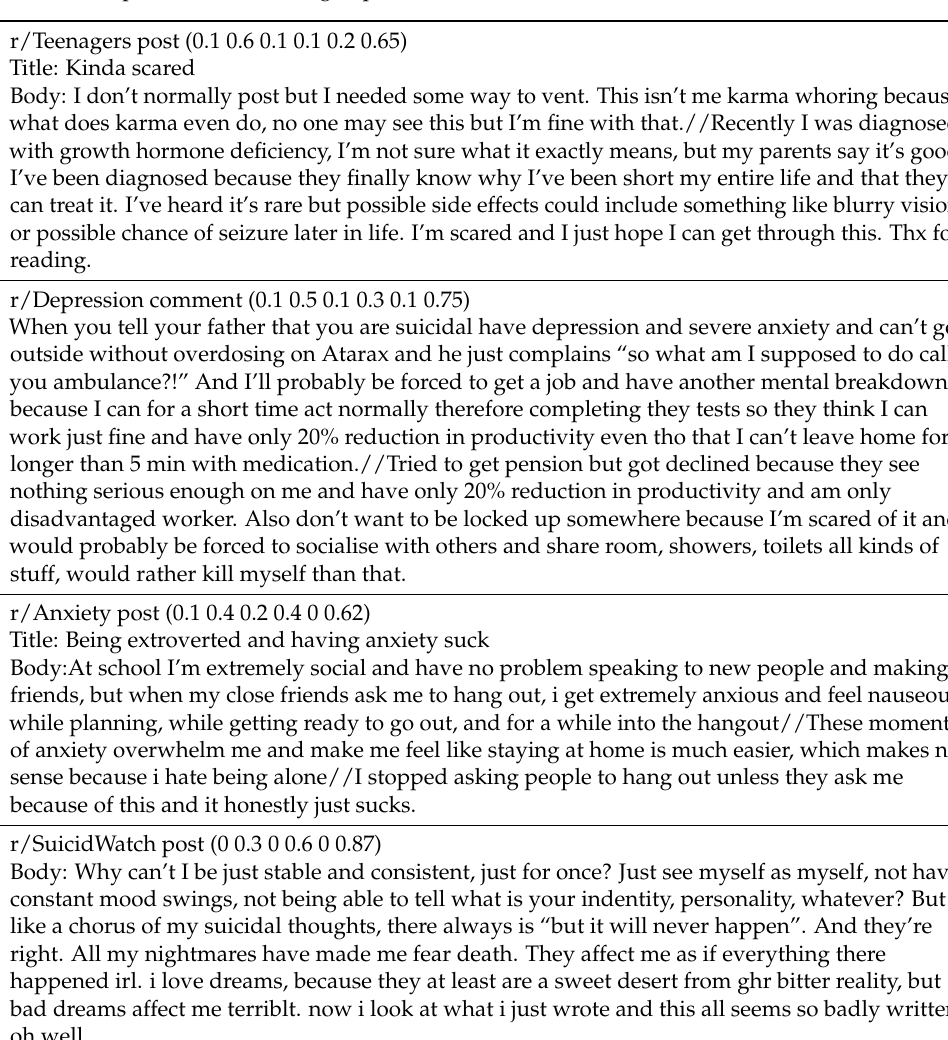
Table 1. Sample emotional coding of